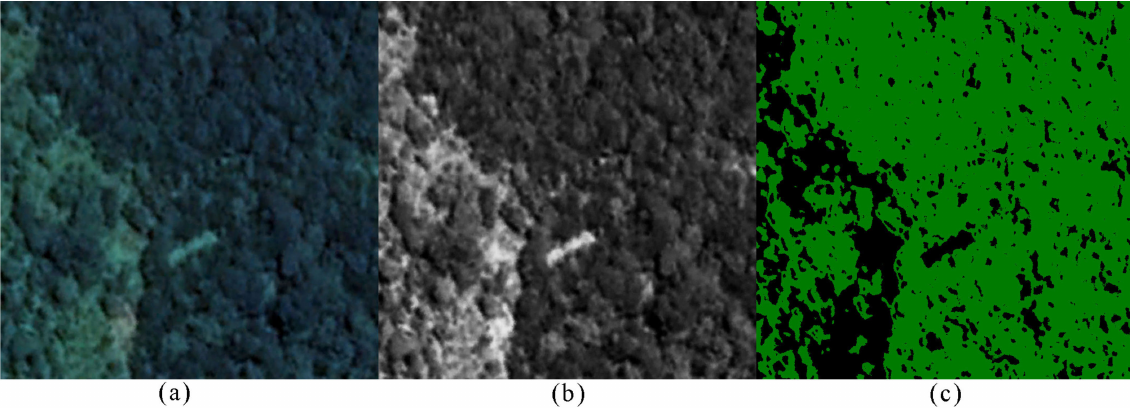
Figure 3. An example of extracting CC using Photoshop and Density Slicing within ENVI. ( a ) Captured image plot on Google Earth using the screenshot function; ( b ) discarding of color and enhancement of brightness and contrast of the plot to 120 (150 at maximum) and 95 (100 at maximum), respectively, in Photoshop; and ( c ) canopy cover rendered by thresholding using the Density Slice tool of